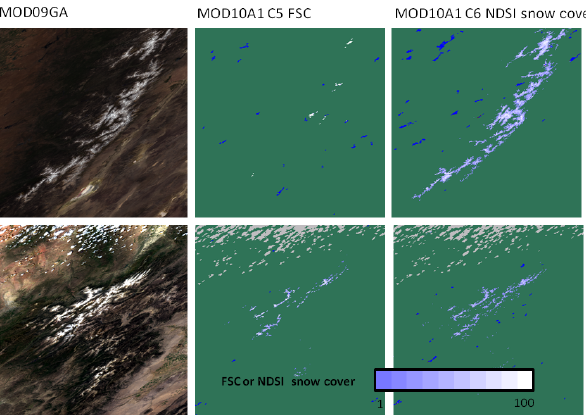
Figure 6. Comparison of snow-cover extent between MOD10A1 C5 and MOD10A1 C6. The Sierra Nevada range on 15 June 2002, top row, and the Upper Rio Grande region on 22 May 2002, bottom row. True color (bands 1, 4, 3) image of the MOD09GA is shown in the left column. Significant snow-cover extent was missed in C5 FSC; however, all the snow-cover extent is detected in C6 NDSI_Snow_Cover by the revised